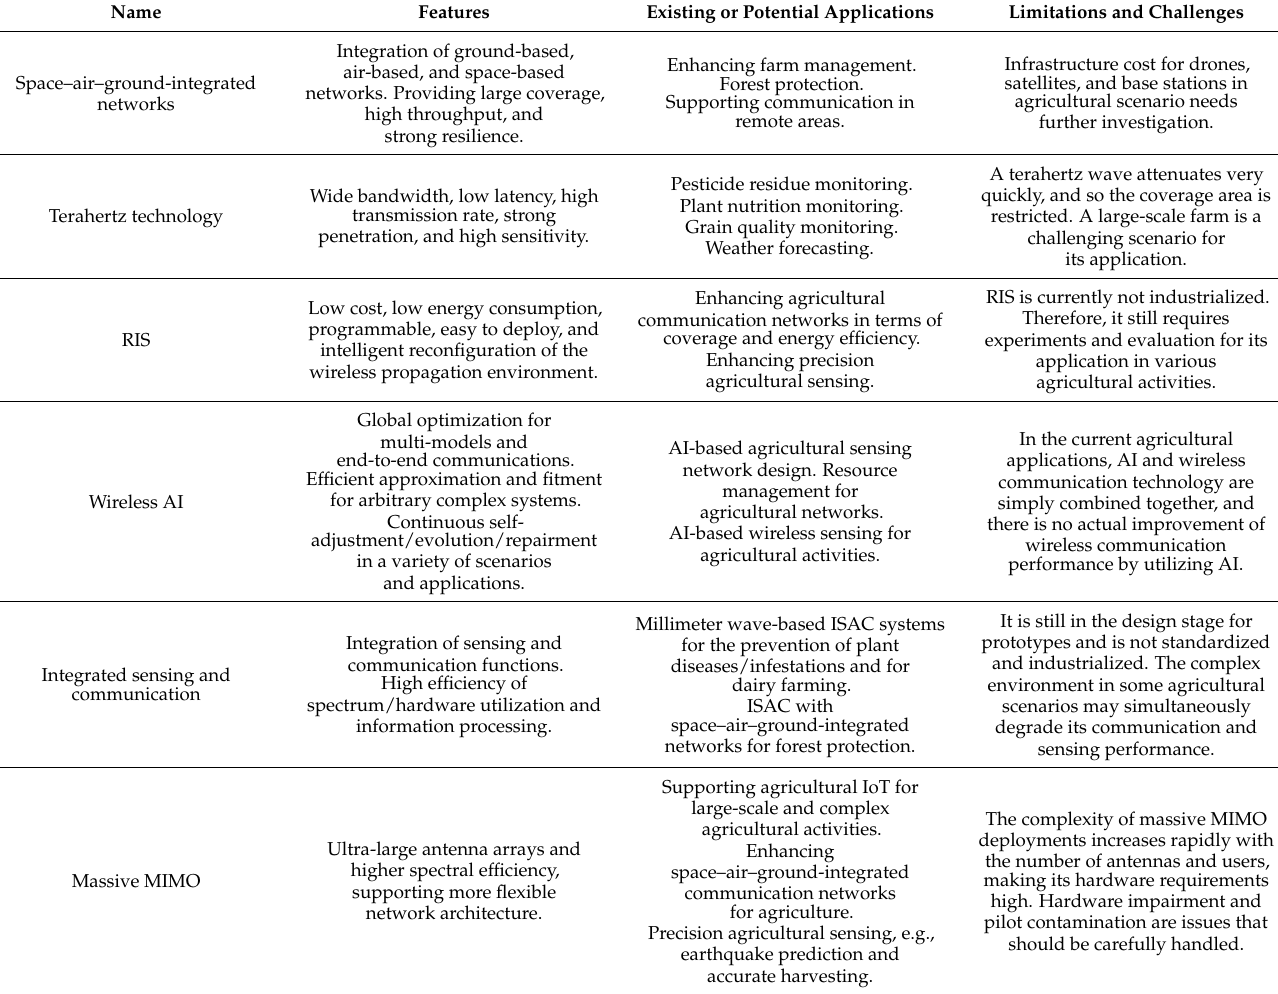
Table 3. 6G technologies in